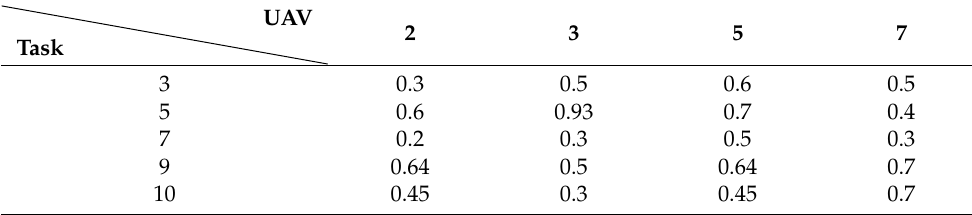
Table 4. UAV damage capability